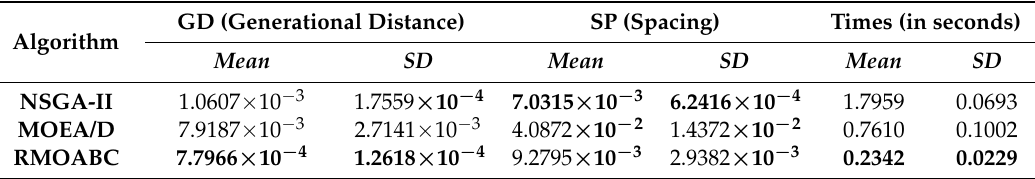
Table 4. Results of the performance metrics for ZDT3 function of the algorithms.